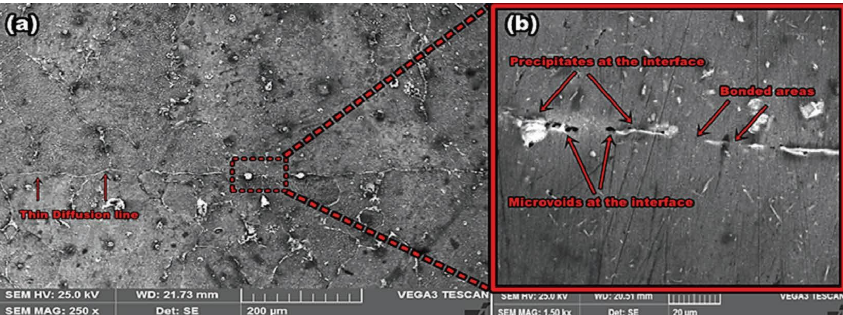
Figure 8: (a) SEM micrographs of the section bonded at 475 ° C and (b) detailed view of the rectangular drawn in